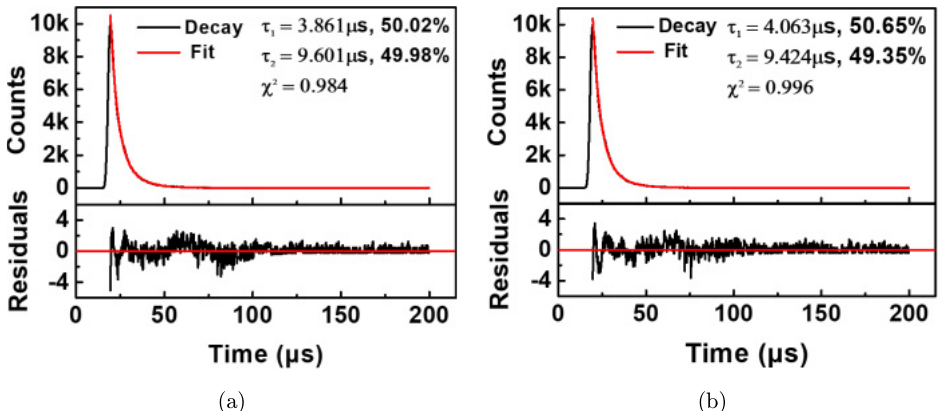
Fig. 4. Photoluminescence lifetime for (a) Au NCs and (b) bimetallic AuAg NCs which are ¯tted with biexponential